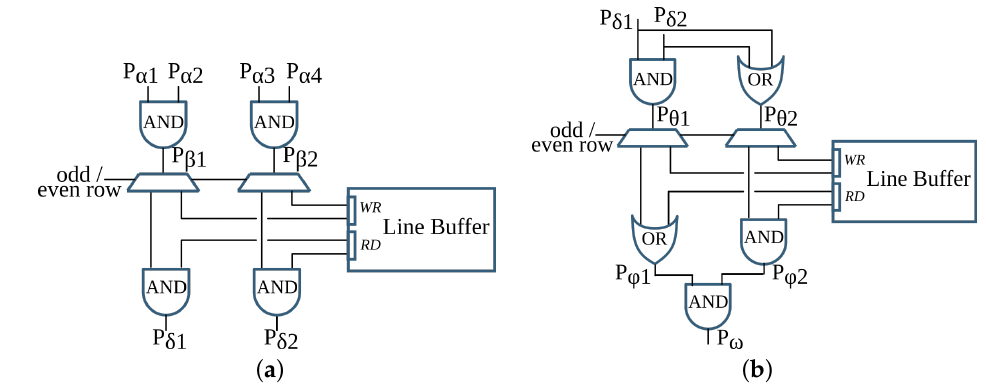
Figure 22. Architecture of the reduction operations with ( a ) with T = 4 and ( b ) with T = 3.